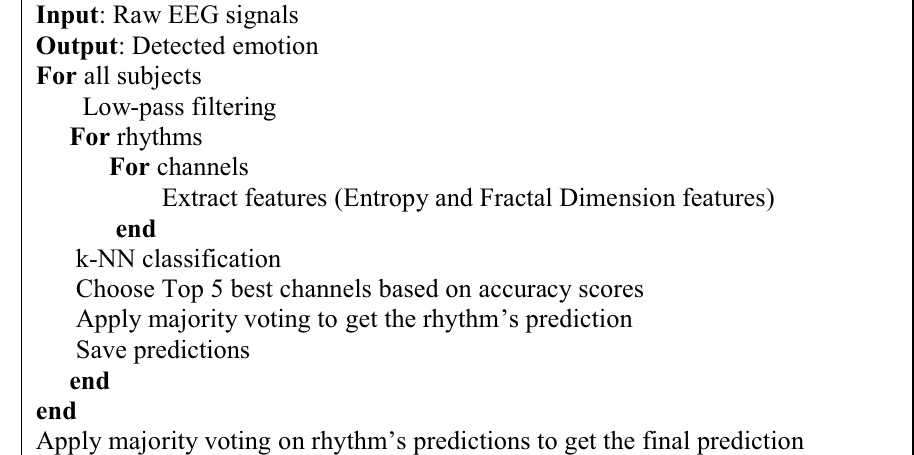
Table 1 The pseudo-code of the proposed